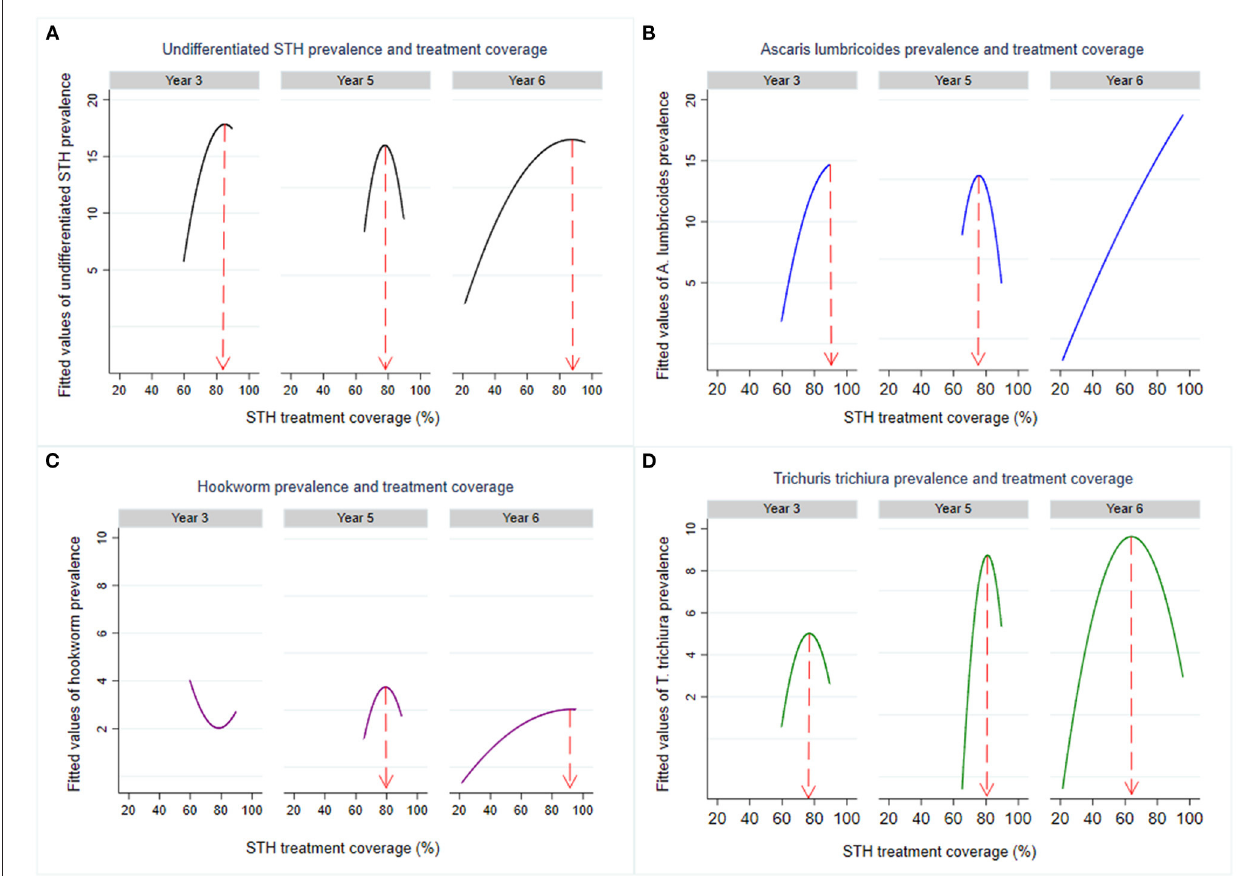
FIGURE 5 | Non-linear relationship between STH infections prevalence ( A : Undifferentiated STH, B : Ascaris lumbricoides, C : Hookworm, and D : Trichuris trichiura) and treatment coverage for year 1, year 3, and year 6 survey time points among the general children population (both PSAC and SAC combined) in Kenya. Note that Year 1 was not displayed since there was no previous year treatment coverage to compare with the baseline